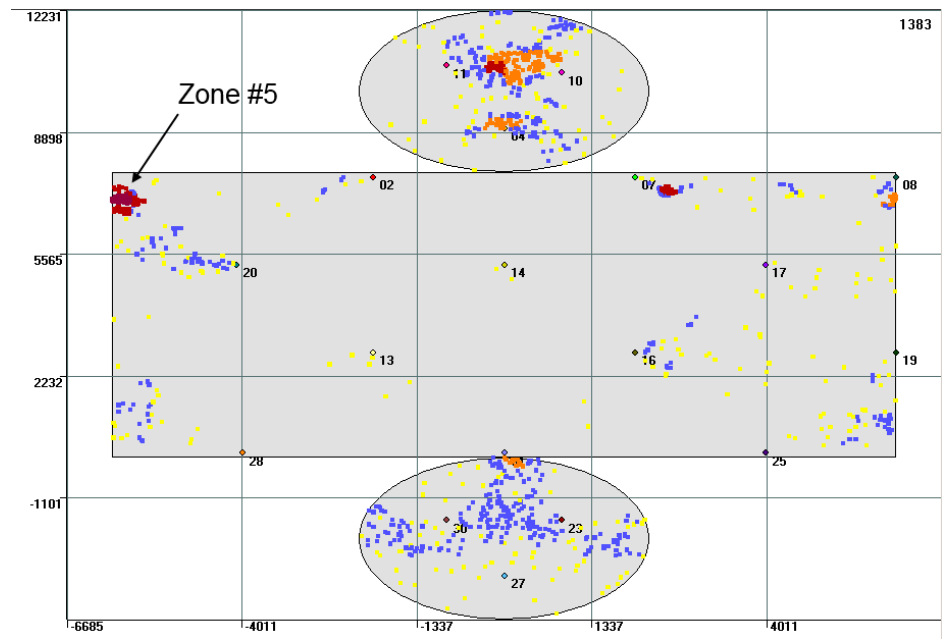
Figure 2. Location map. Color of points mean quantity of location events. Blue points: 1–2 events, yellow: 3–10 events, orange points: 11–25 events, red points: 26–100 events, brown points: more than 100 events.